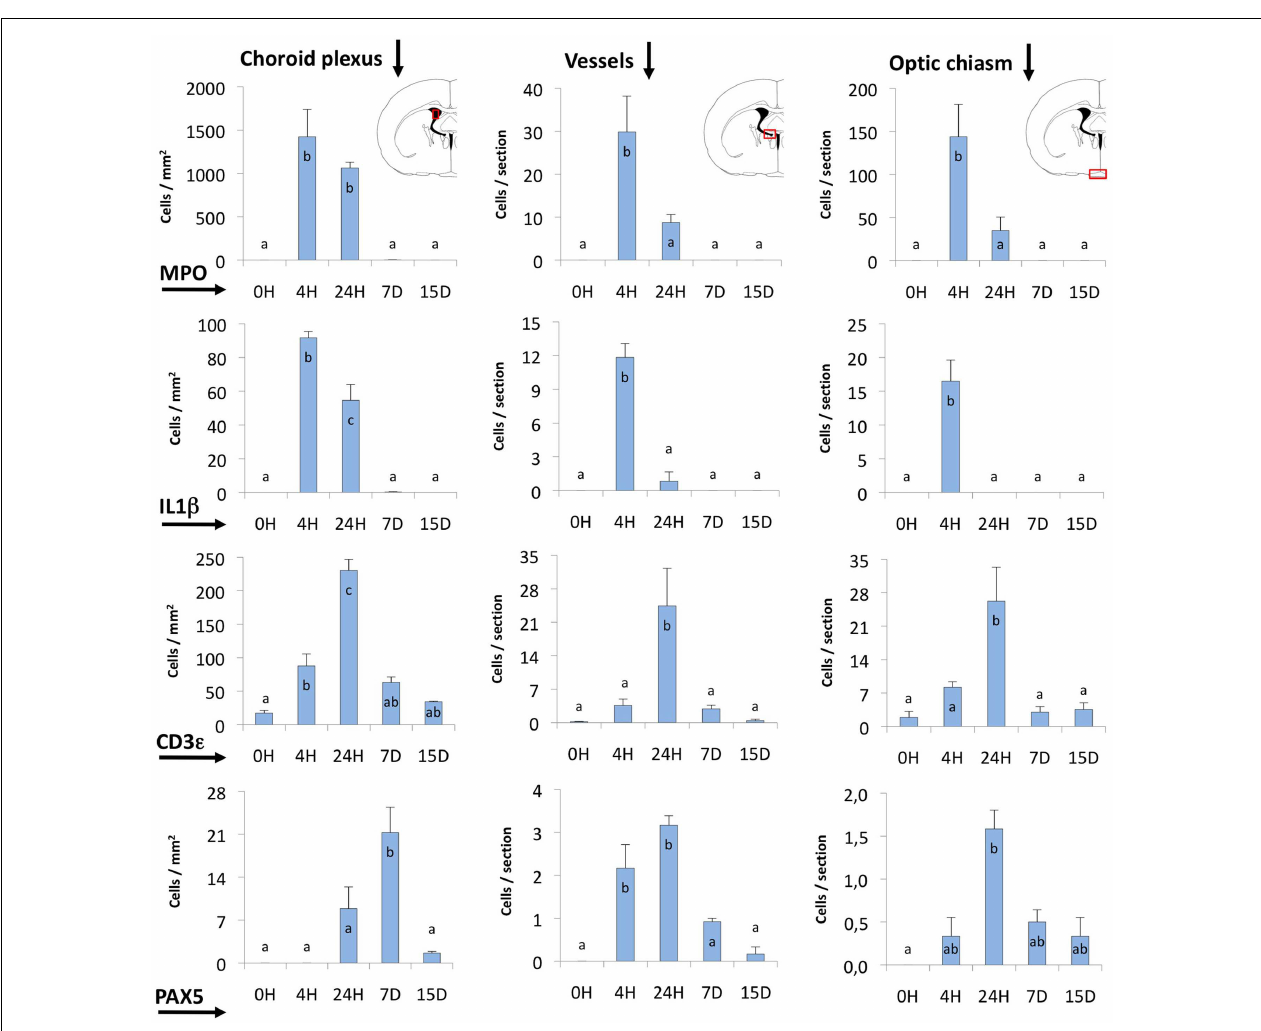
cells, respectively) reached a maximum before 24h.The peak of CD3 ε and PAX5-positive cells (probablyT- and B-lymphocytes) occurred later, and these cells remained longer (even up to 15days) in some locations.The bars represent the mean ± SEM of five animals. Letters (a–c) on bars indicate the absence (same letter) or presence (different letter) of a significant difference between groups ( α = 0.05).Time 0 post-injection of NA (0h) is considered the baseline population of positive